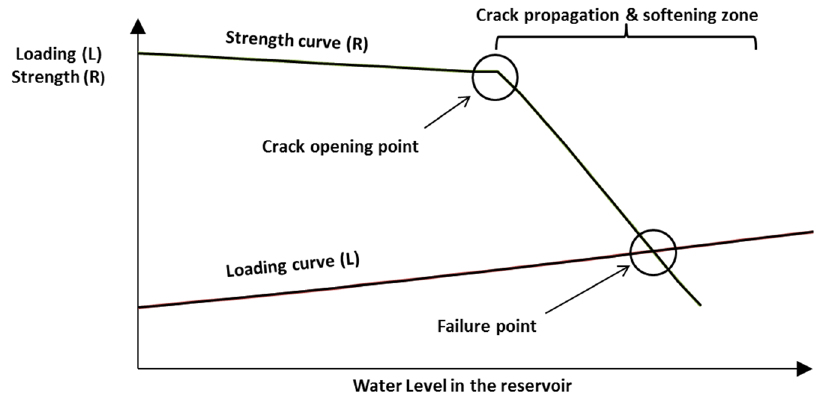
Figure 1. Reduction of sliding strength with pool levels.